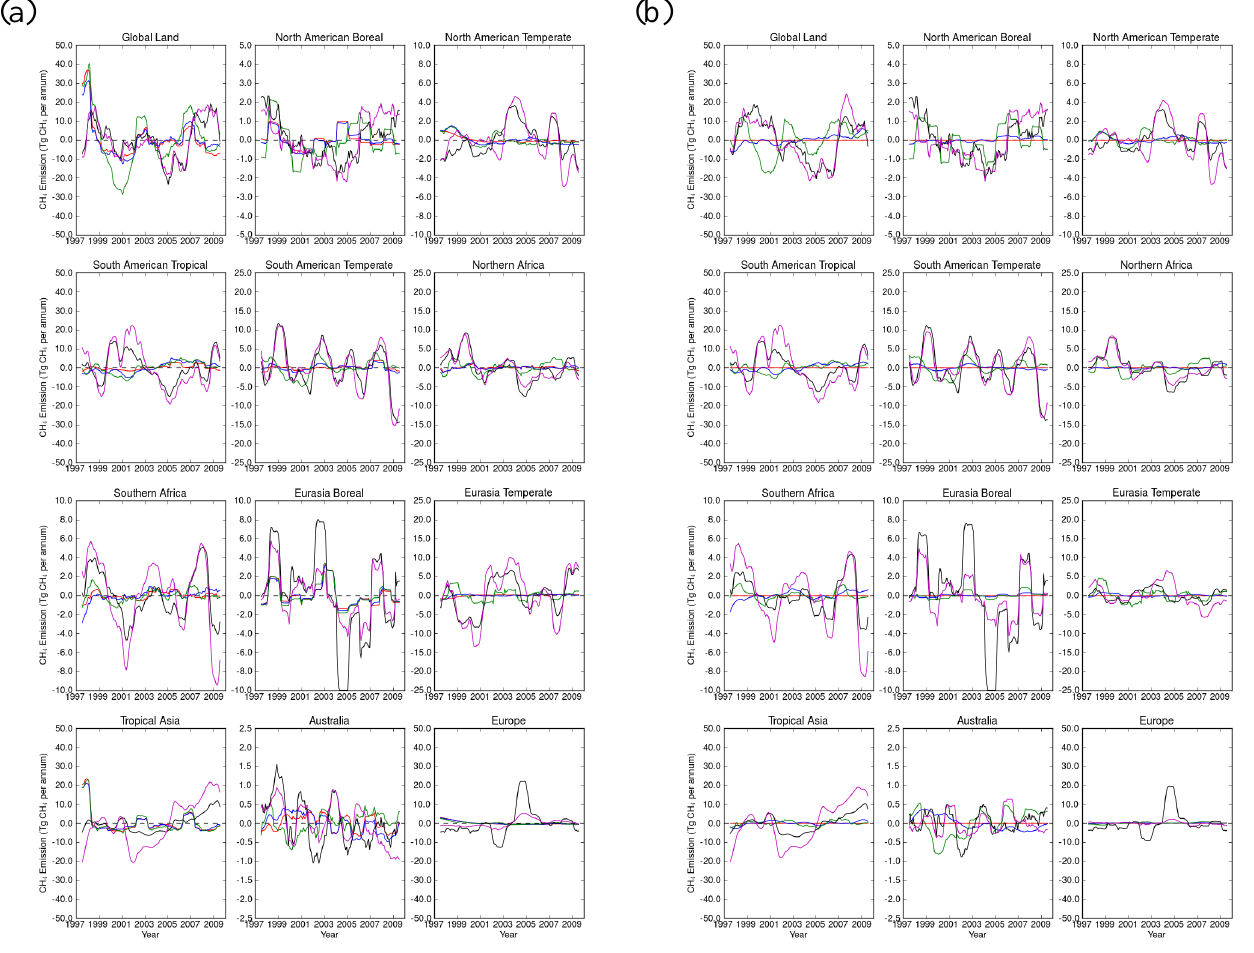
Figure 11. Comparison of the deseasonalized emission fluxes between 1997 and 2009 from the HadGEM2 runs (using the wetland emission inventories: FUNG – red, JULES – blue and JULES-GIEMS – green) and the two inverse flux estimates of Bousquet et al. (2011) (black and purple). (a) and (b) show the anomalies in the global methane emissions and in the wetland emissions,